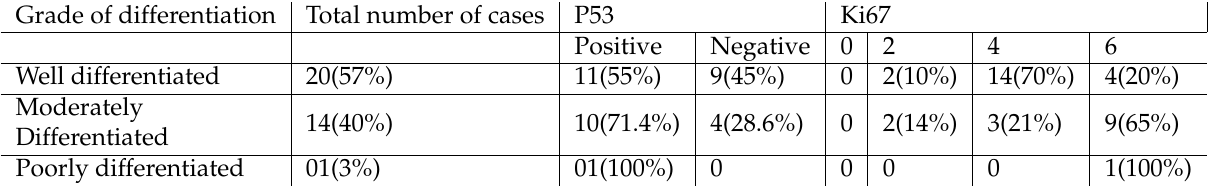
Table 3. Grades of differentiation of oral squamous cell carcinoma correlation with p53 expression and ki67 proliferative